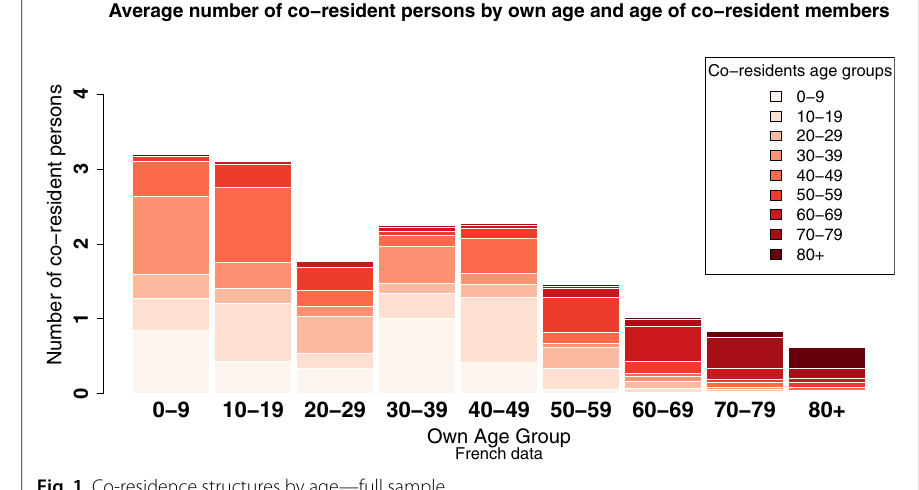
Fig. 1 Co-residence structures by age—full sample